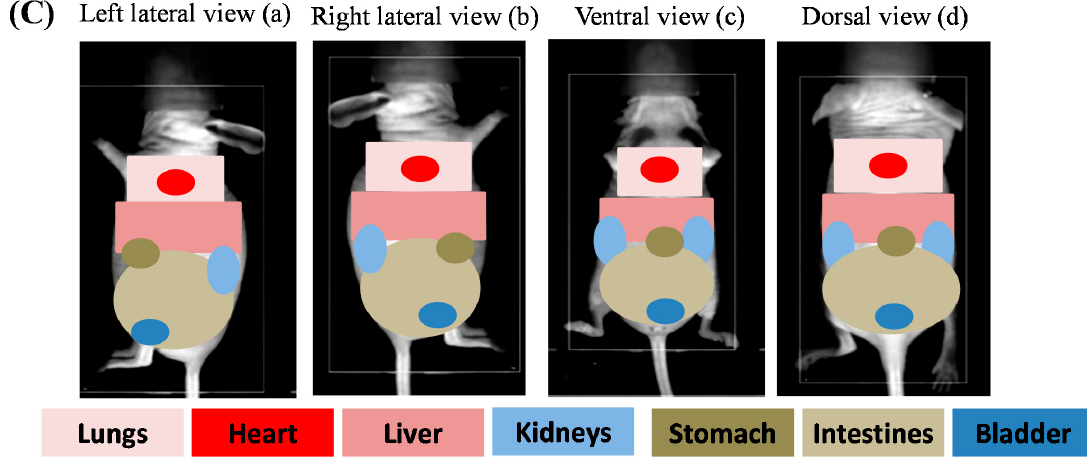
Figure 5. FL1C-based liposomes and biodistribution of lipoplexes at different times (1, 3, 5 and 24 h). FL1C, FL1C + DSPE-PEG 2000 , FL1C/pGM144 and FL1C + DSPE-PEG 2000 /pGM144 were administered intravenously in nude mice ( n = 4). BFI measurements and BFI images were taken in different positions ( A , B ); left lateral view ( a ), right lateral view ( b ), ventral view ( c ) and dorsal view ( d ) using the Nightowl II system (Berthold Technologies, Bad Wildbad, Germany) to localize all fluorescent organs, and global fluorescence intensity of FL1C-based complexes ( n = 4) were compared ( A ). As an illustration, one mouse per experiment was represented in the different positions ( B ). In panel ( C ) was represented a schematic localization of several organs in each projection employed to clearly identify organs involved. Results were represented as photon/pixel/second reflecting the fluorescence intensity as the mean ˘ SD of four mice ( * p < 0.05). The sensitivity scale of the software Winlight 32 was blocked to allow the comparison of the